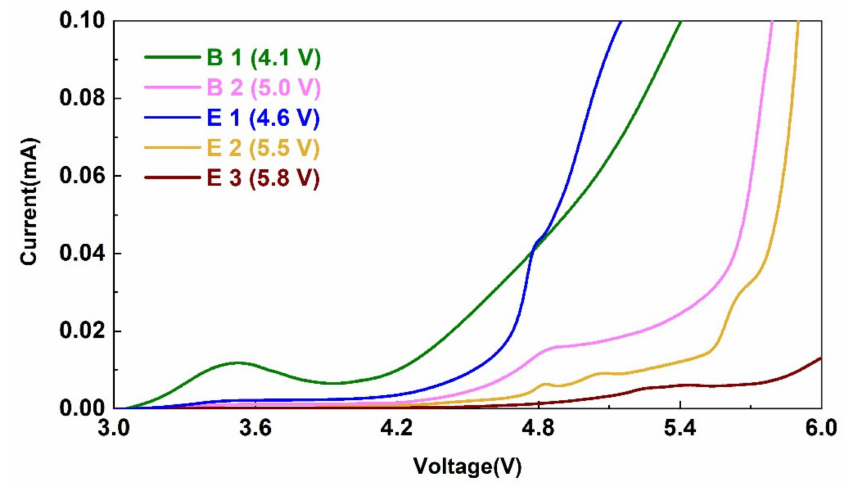
Figure 1. Linear scanning voltammetry curves in different